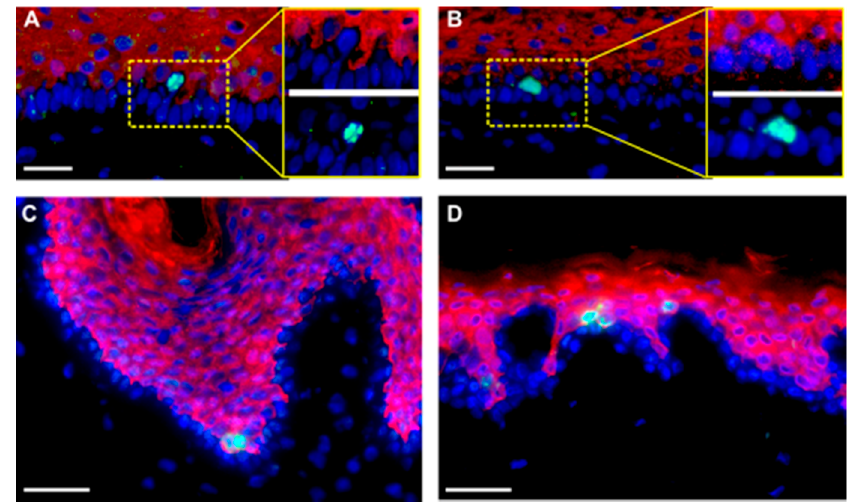
Figure 2. Suprabasal division is not an uncommon feature of the human homeostatic epidermis in SE and human skin in situ . ( A , B ) Sections of the SE, five weeks old and ( C , D ) normal human skin were stained with anti-H3Sph10 (green) to visualize mitotic cells and anti-K10 (red) to show differentiating cells. Suprabasally-dividing cells were frequently found in both systems. Error bars A – D : 100 µm.